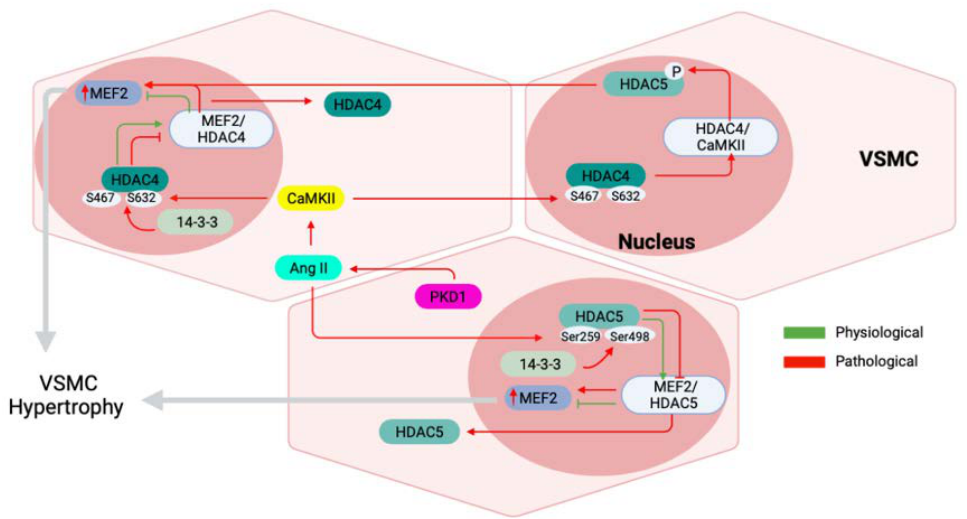
Figure 3. Pathological mechanisms of VSMC hypertrophy. Angiotensin II (AngII) leads to phos- phorylation of HDAC4/5 chaperone 14-3-3 binding sites through CaMKII-dependent (HDAC4) and CaMKII-independent (HDAC5) mechanisms. Under physiological conditions, HDAC4/5 forms com- plexes with myocyte enhancer factor-2 (MEF2). Under pathological conditions, complex formation is downregulated and MEF2 leads to activation of hypertrophic genes for contractile proteins such as beta-MHC, atrial natriuretic factor (ANF), and transcription factor KLF5, leading to VSMC hypertrophy.